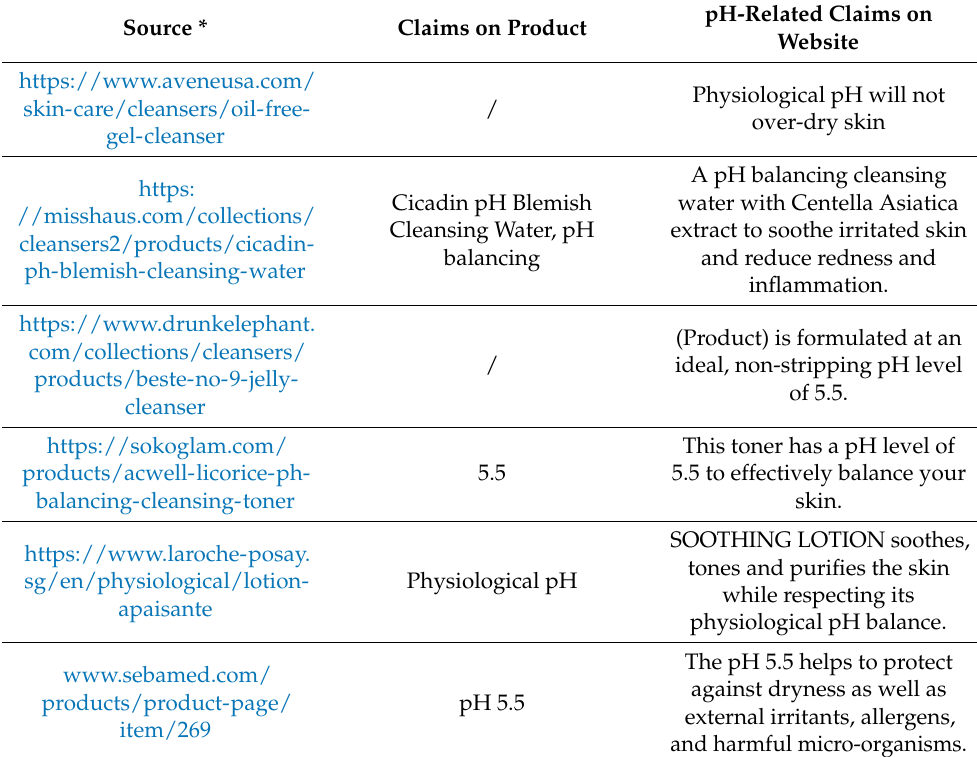
Table 1. Claims/information related to a product’s pH or its effect on the skin